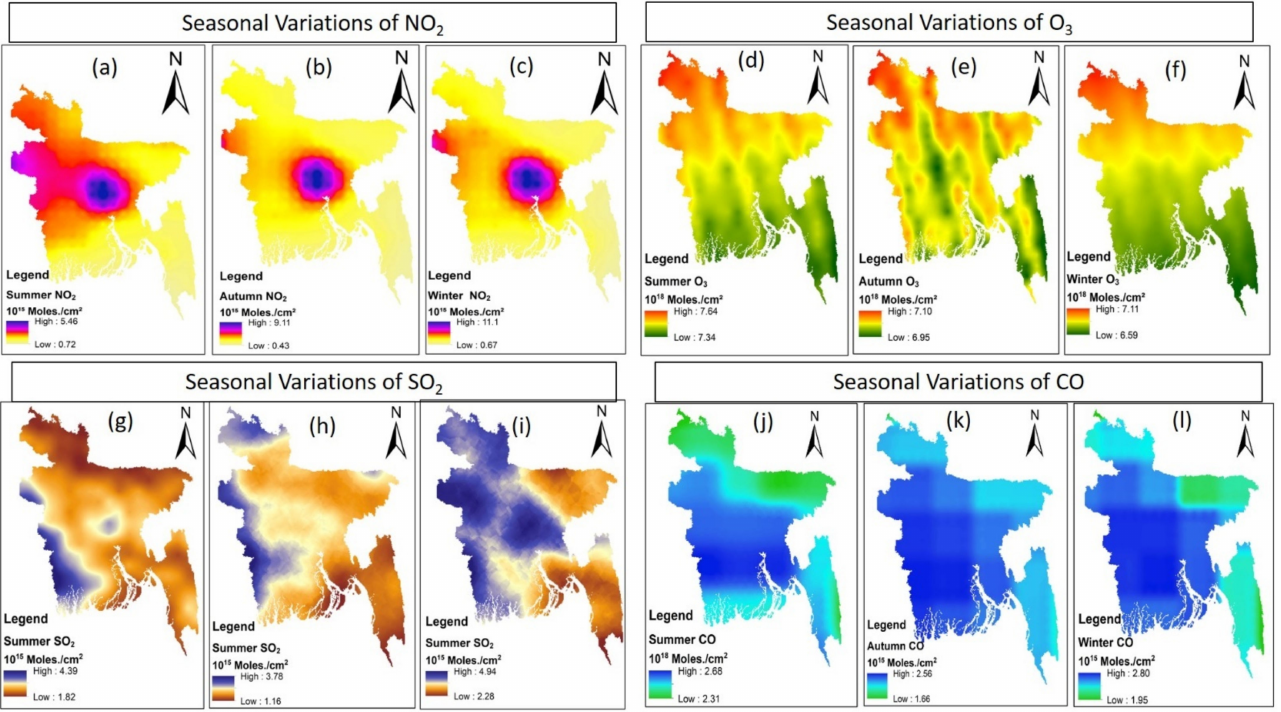
Figure 4. Six-year (2015–2020) average seasonal variations in air pollutants. ( a – c ) NO 2 , ( d – f ) O 3 , ( g – i ) SO 2 , ( j – l )